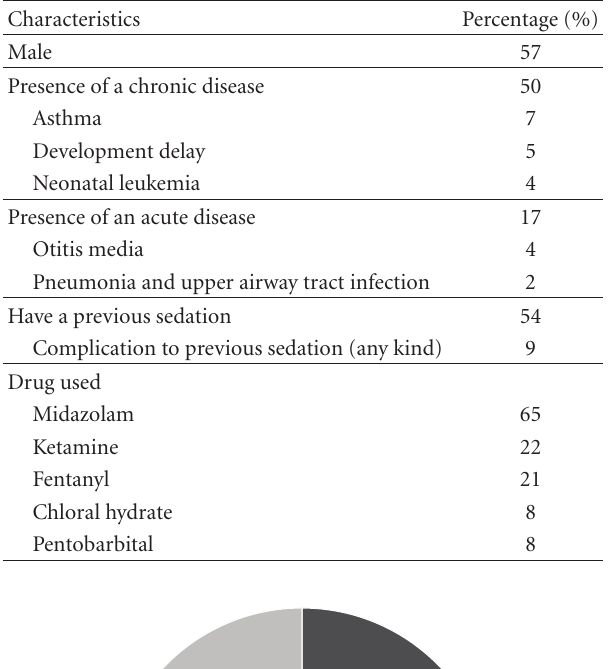
Table 1: Population characteristics.